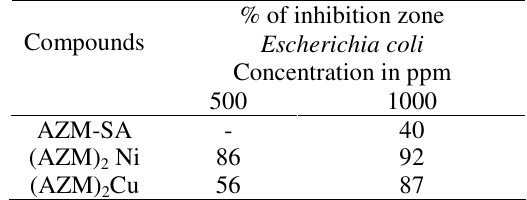
Table 4. Antibacterial activity of Schiff base and